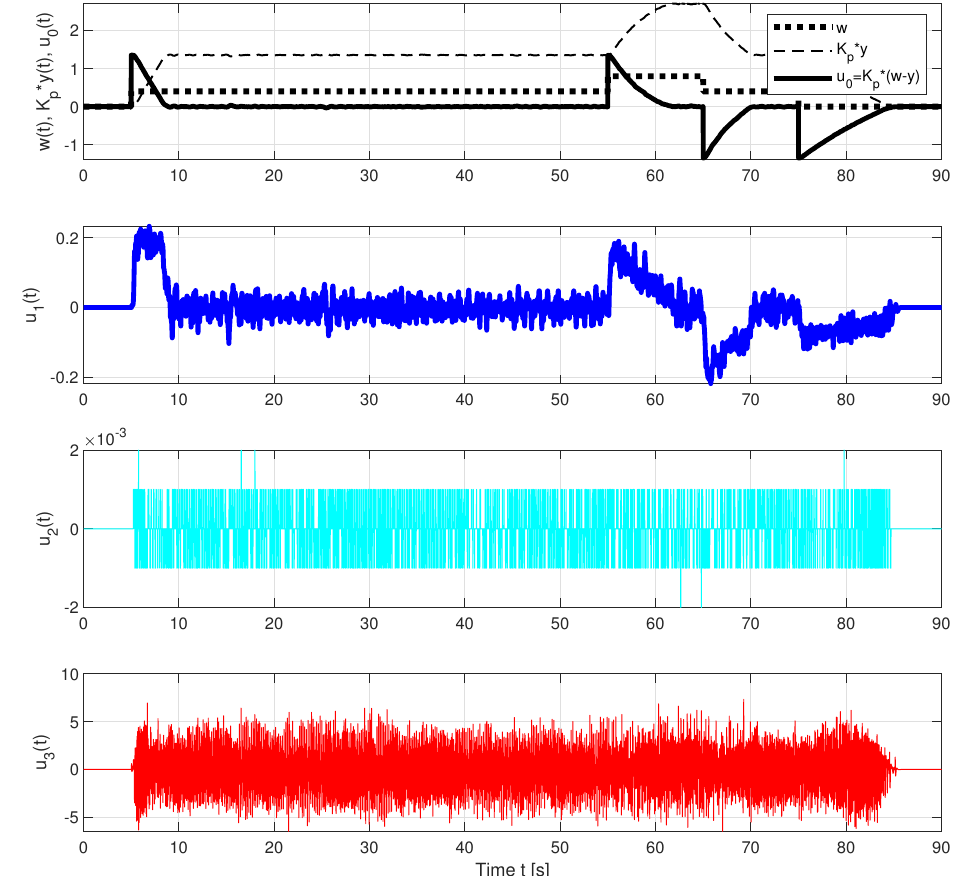
Figure 10. Individual control components of the PIDAJ controller corresponding to different control error derivatives and the transients according to Figure